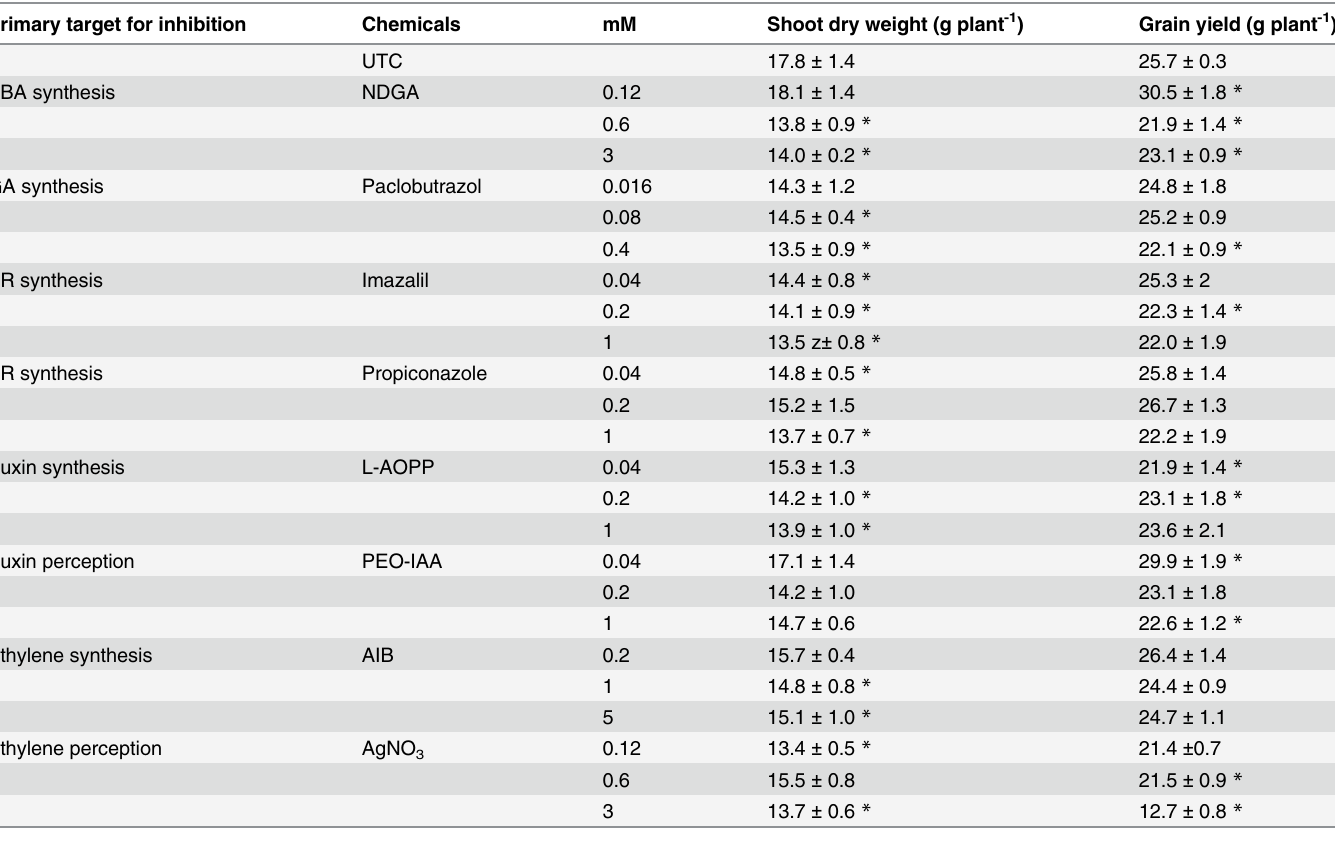
Table 2. Effects of plant hormone inhibitors applied at both pre-anthesis and post-anthesis on the biomass production and grain